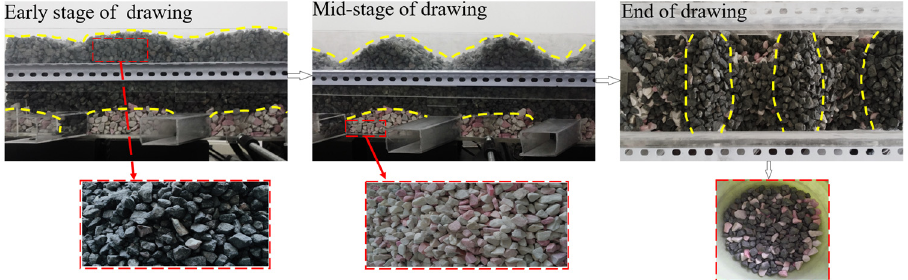
Figure 11. The drawing process.